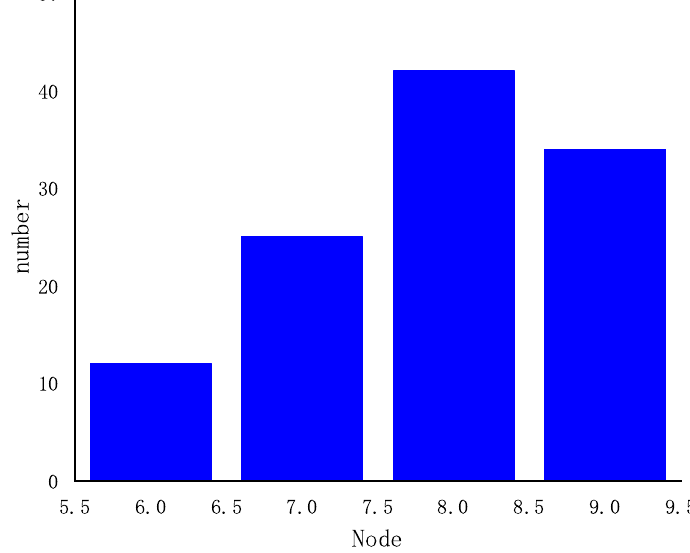
Figure 15. Degree distribution of SW network.